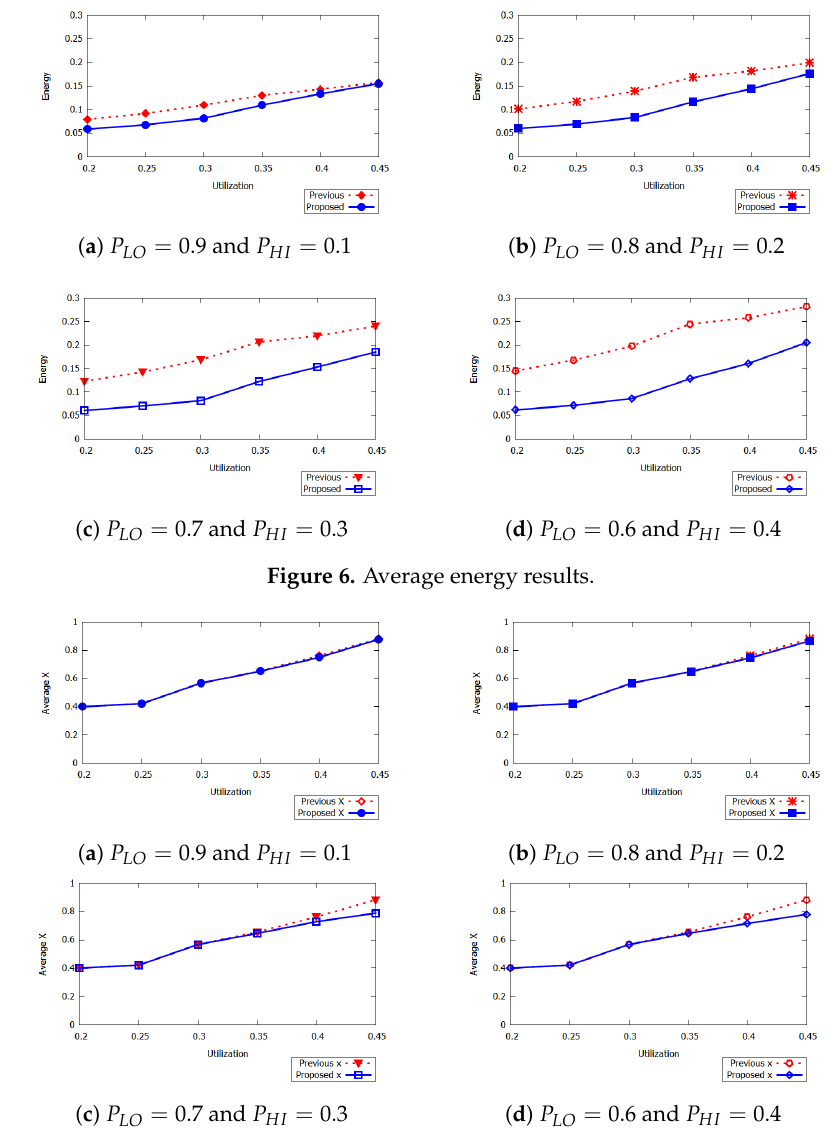
Figure 7. The impact of x